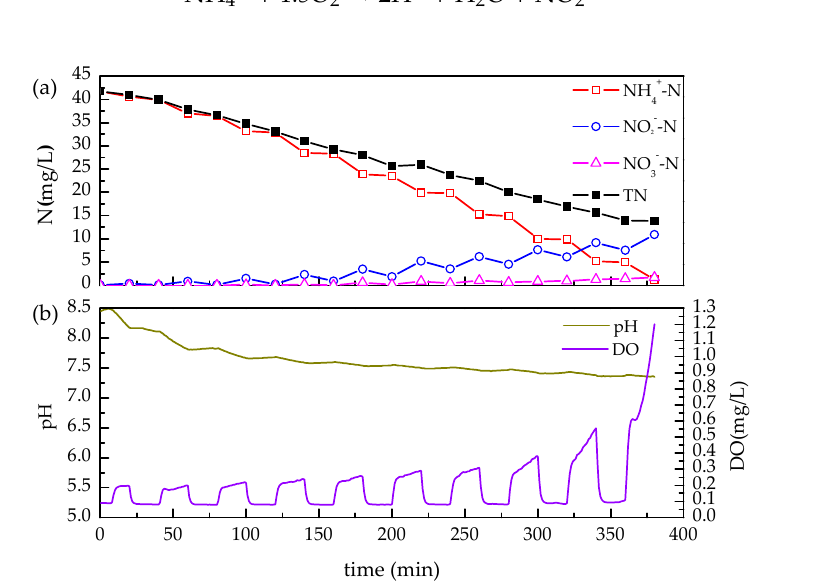
Figure 3. Variation in nitrogen species concentrations, pH, and dissolved oxygen (DO) in a typical cycle (cycle 162): ( a ) NH 4 + -N, NO 2 − -N, NO 3 − -N, and TN; ( b ) pH and DO.